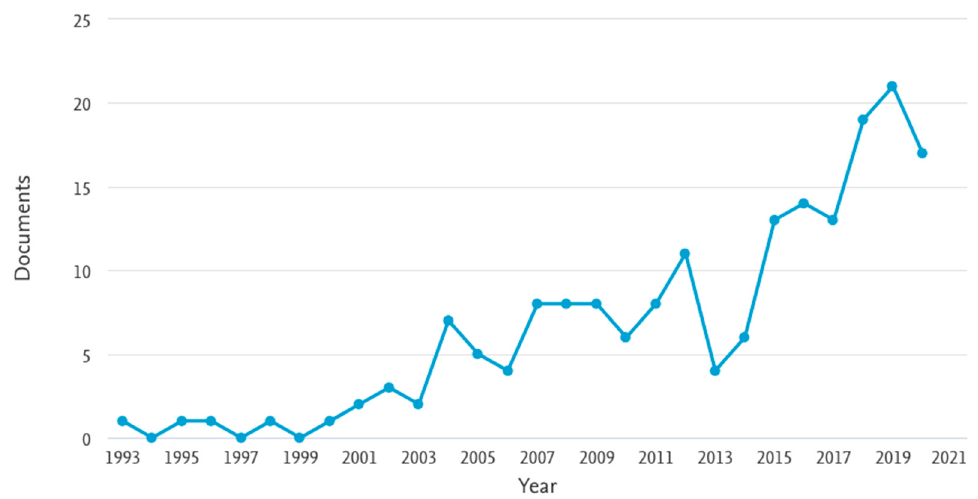
Figure 1. N. of published articles on Information and Communication Technologies (ICT) adoption in agriculture water management. Source: own elaboration from data obtained with the search in Scopus (dated 30 / 08 / 2020) having the following parameters: TITLE-ABS-KEY ((ICT OR DSS OR “climate services”) AND agriculture AND (“water management” OR irrigation)).